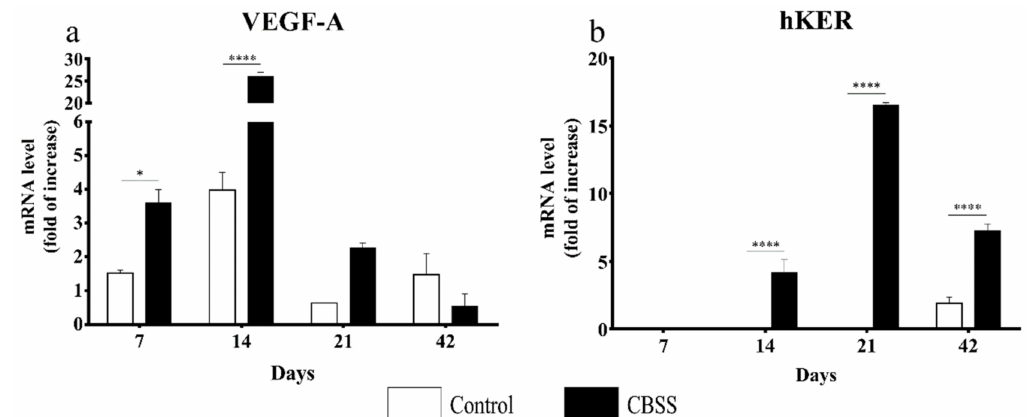
Figure 10. Gene expression analysis for VEGF and hKER genes ( a ) Relative expression of the vascular endothelial growth factor A (VEGF-A) gene and ( b ) hair-Keratin (hKER) gene at 7, 14, 21, and 42 days after wounding in control and CBSS- treated wounds. Data are shown as mean ± SEM. Unwounded skin was used as the calibrator sample. Statistical differences were measured between the two experimental groups at the same time point. * p < 0.05; **** p <